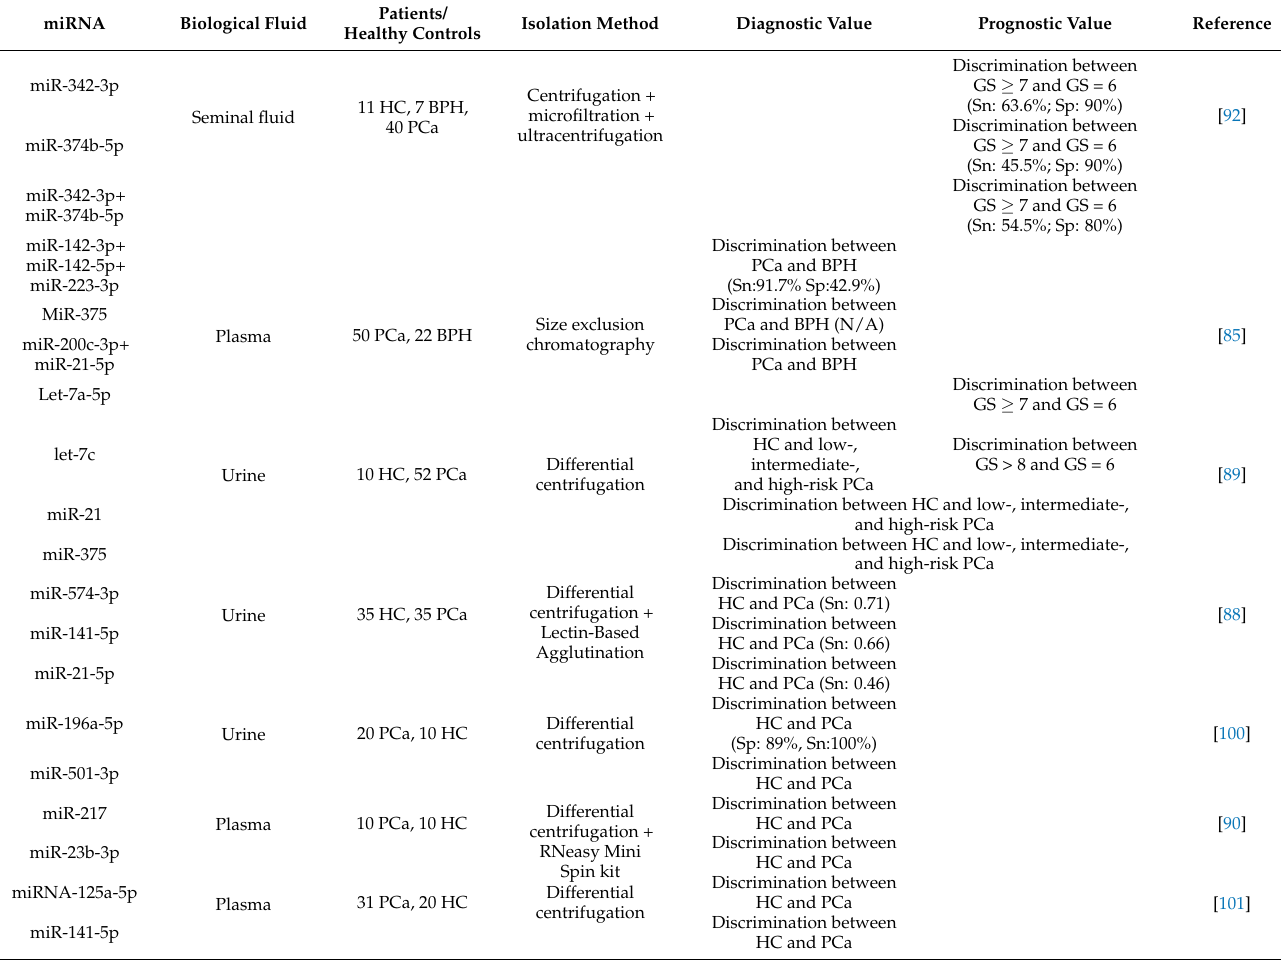
Table 1. Diagnostic and prognostic value of miRNAs in patients with non-metastatic